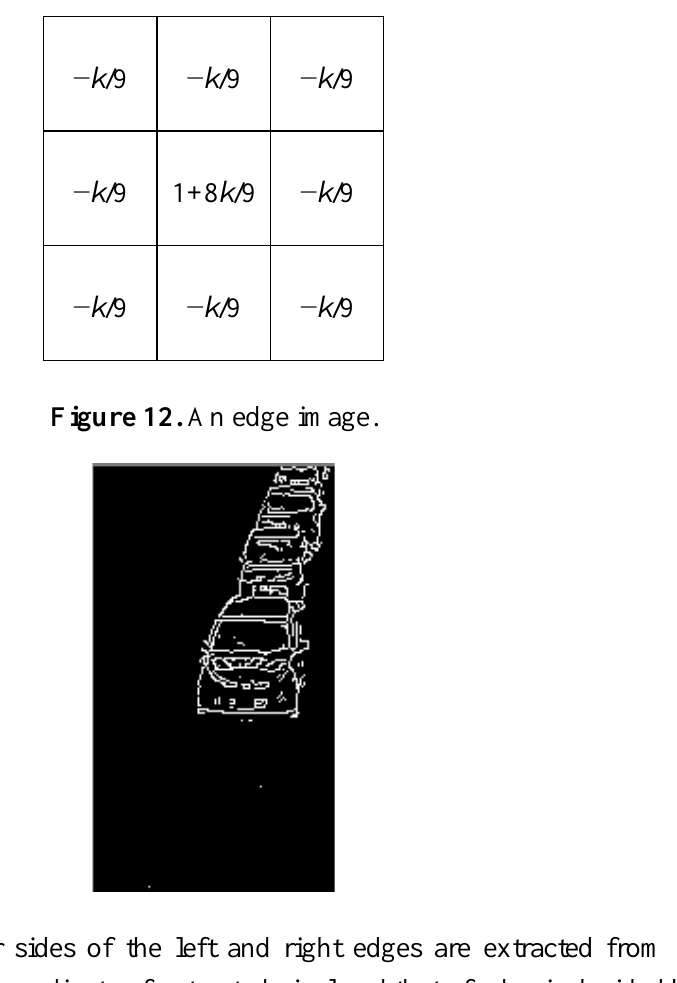
Figure 11. The kernel for unsharp masking.